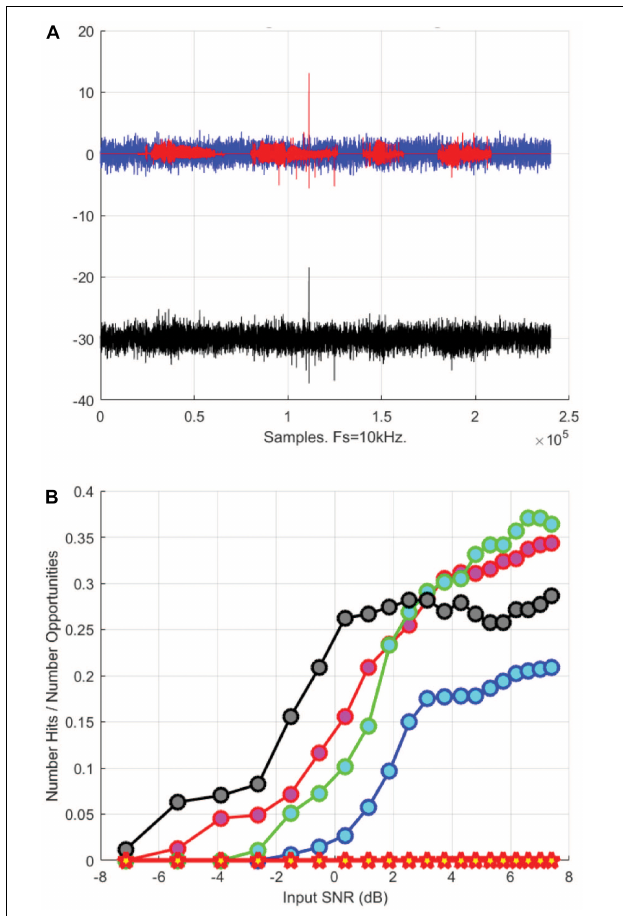
FIGURE 5 | (A) Five sound velocity profiles (SVPs) near Red Hind Bank spawning aggregation site that were used to estimate transmission loss of red hind grouper sounds. (B) Signal to noise ratio (SNR) (dB) variation with distance (meters) from a source at 2 m above bottom. The red line shows the –3-dB detection threshold (DT) estimated for the PAM and the black line the 2-dB SNR. This 5-dB detection margin is representing variations in the false alarm rate